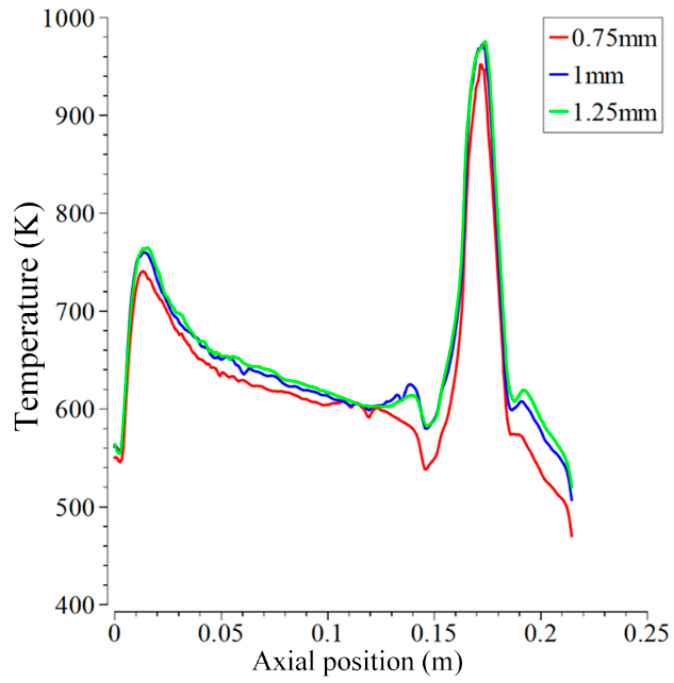
Figure 14. Wall temperature curves under different rib height conditions. Figure 15a shows the wall temperature maxima for different rib heights and the average coolant outlet temperature. As seen in the figure, as the rib height increased, the temperature of the inner wall in the thrust chamber rose. However, the magnitude of the change was not large and basically stayed within 20 K. At the same time, with the increase in rib height, the average temperature of the coolant outlet had a relatively small decrease, and the amount of change was very small. The heat transfer of regenerative cooling was affected by a combination of factors, including the contact area between the coolant and the cooling channel, the rib efficiency, and the degree of convective heat transfer. Under the premise of a constant rib width, increasing the rib height increased the entire cooling channel area and the contact area between the coolant and cooling channel, and the rib efficiency also increased, enhancing the heat transfer effect. At the same time, the coolant flow rate remained unchanged; increasing the cooling channel area led to a decrease in the coolant flow rate and a decrease in the convective heat transfer coefficient, thus decreasing the heat transfer and increasing the wall temperature to a certain extent. In this process, the influence of the latter dominated, so the increase in rib height weakened the heat exchange effect. The coolant pressure drop for different rib height conditions is shown in Figure 15b.